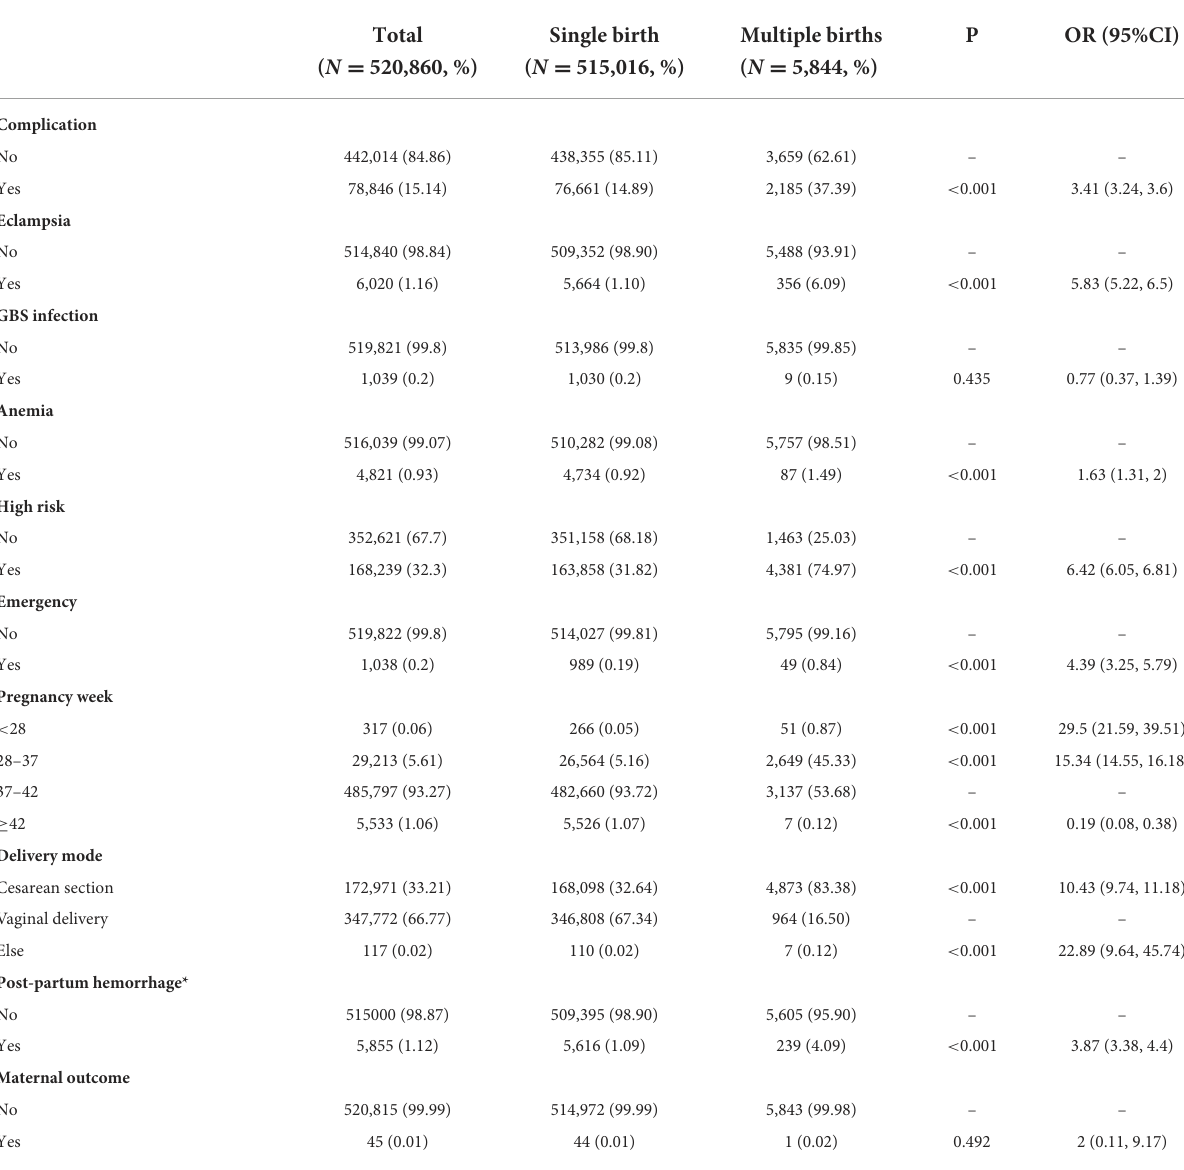
the results in Table 2 and Supplementary Table S2. During the past 11 years, the proportion of multiple births has increased yearly since 2013 compared with 2009 ( p < 0.05). During this period, the male-to-female ratio was 1.18 for singleton births and 1.11 for multiple births. For multiple births, the mortality rate (OR = 0.140, 7-day mortality OR = 3.66), malformation rate (OR = 2.01) and neonatal asphyxia rate (Apgar score at 1 and 5min) were higher than those of single births. Additionally, the results of stratified analysis showed that the main intrauterine growth and development indicators of multiple fetuses were lower than those of singleton fetuses, including weight, height, head circumference,